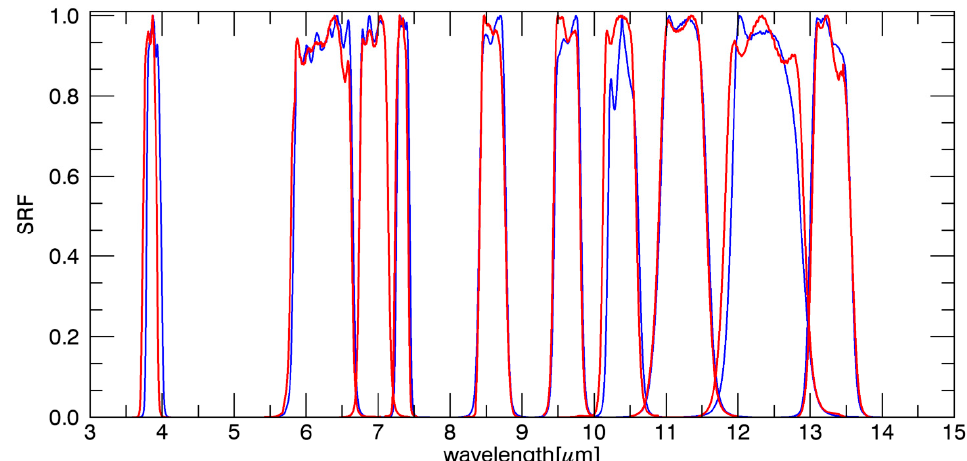
Figure 11. IR channel spectral response function of AMI (red line) and Advanced Himawari Imager (AHI) (blue line).